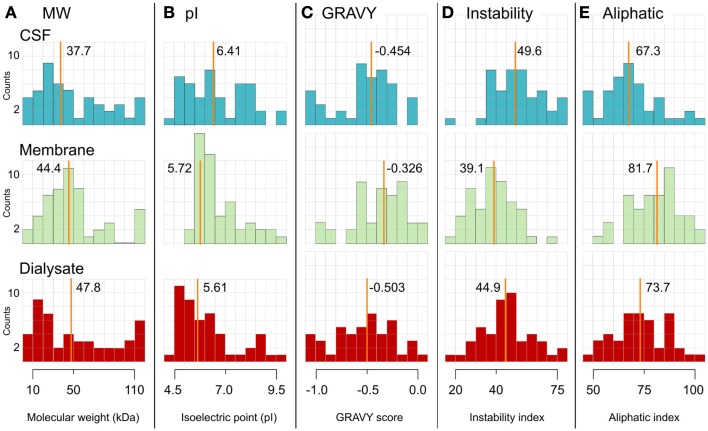
Distribution histograms for proteins in CSF, on the MD membrane, and in the dialyzate are shown. Protein distribution histograms for protein properties of the proteins identified in CSF (top, blue), adsorbed to the MD membrane (middle, green) and in the dialyzate (bottom, red). The 11 proteins found in all samples are excluded. The proteins are divided in fractions depending on their calculated number of each property. The investigated properties are (A) molecular weight, (B) isoelectric point, (C) GRAVY score, (D) instability index, and (E) aliphatic index. The y-axis is the number of proteins found within the range (x-axis). The line in each histogram represents the median value, which is also written next to the line, n = 59 for CSF, n = 63 for membrane, and n = 59 for dialyzate. The proteins adsorbed onto the membrane had a significantly lower instability index (i.e., more stable), were more hydrophobic (i.e., higher GRAVY score), and were more thermostable (i.e., higher aliphatic index), compared to the proteins in the CSF and the dialyzate. The results suggest that proteins may escape detection because they are adsorbed onto the MD membranes and thereby prevented from passing the membrane into the dialyzate [(13), Figure S1 in Supplementary Material]. Reprinted with permission from Wetterhall et al. (13). Copyright 2014 Elsevier.